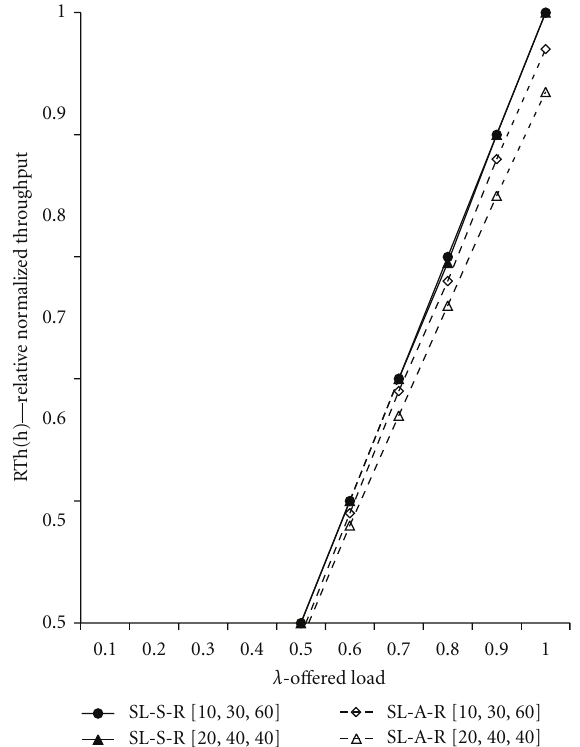
Figure 3: Relative normalized throughput of high-priority packets versus o ff ered